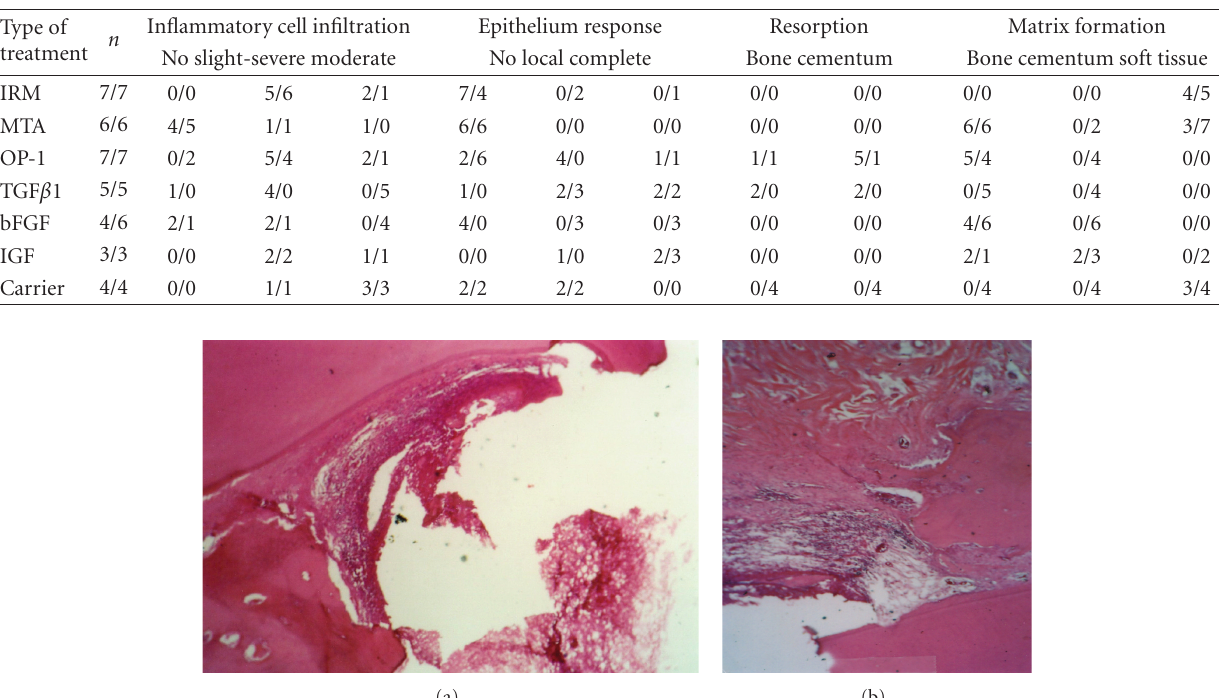
Table 1: Periodontal tissue reactions, including inflammatory cell response, epithelium proliferation, bone and root resorption, and matrix formation, classified according to criteria of histological assessment (see in the text).